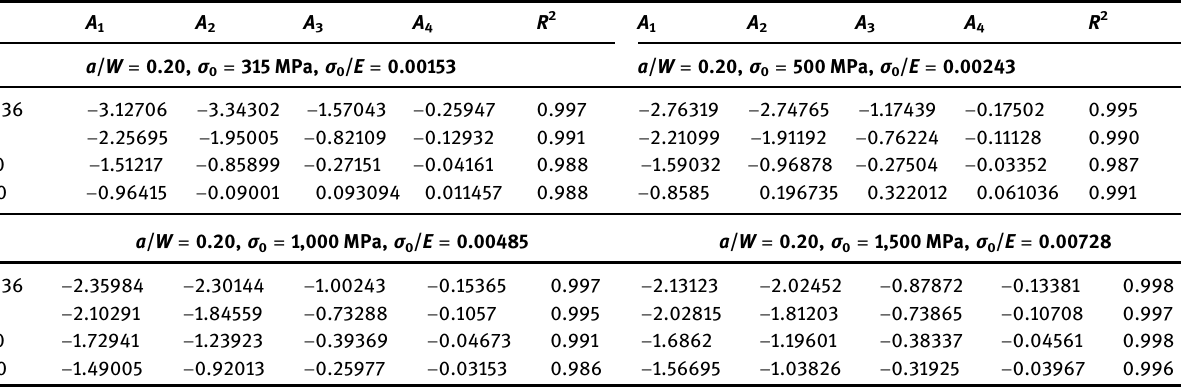
Table 12: Coe ffi cients of matching formula ( 33 ) to the numerical results for the estimation of the Q stress values, for SEN ( 4PB ) specimens dominated by the plane strain state, with the relative crack length a / W = 0.20